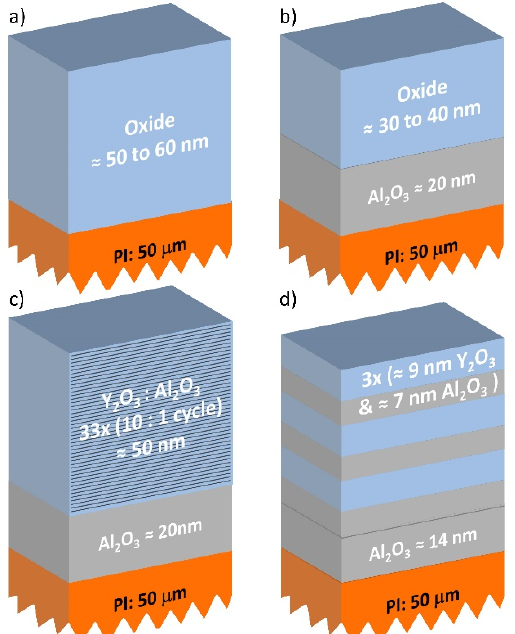
Figure 1. Schematic representation of the thin film geometries studied in this work: ( a ) oxide on polyimide (Al 2 O 3 , ZnO, Y 2 O 3 ), ( b ) oxide on interfacial Al 2 O 3 on polyimide (Y 2 O 3 , TiO 2 , ZrO 2 ), ( c ) aluminum oxide-doped Y 2 O 3 on interfacial Al 2 O 3 on polyimide, ( d ) Al 2 O 3 –Y 2 O 3 nanolaminate on interfacial Al 2 O 3 on polyimide.